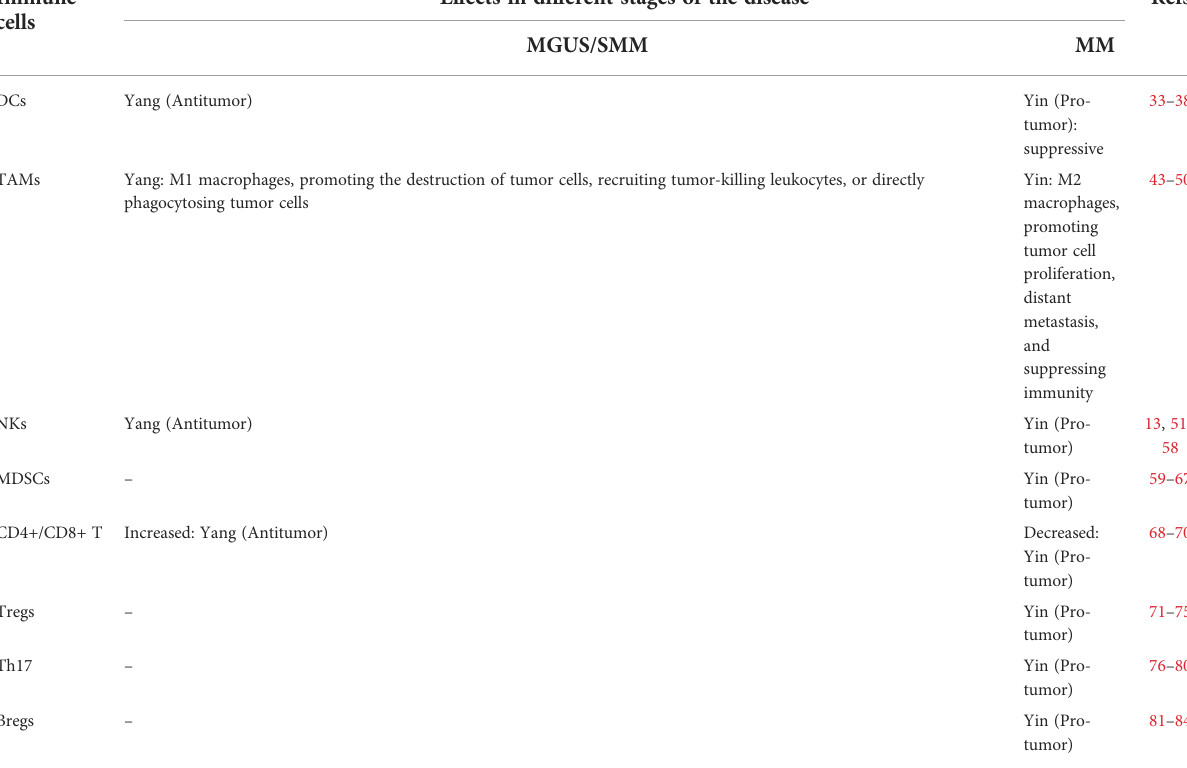
Effects in different stages of the disease